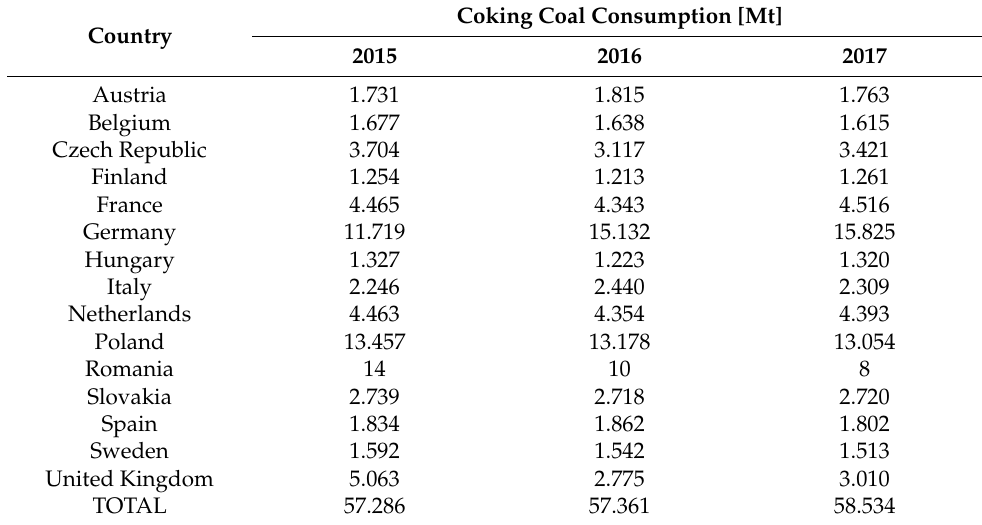
Table 1. Major coking coal consumers in Europe, presented in megatons [10]. Coking Coal Consumption Country